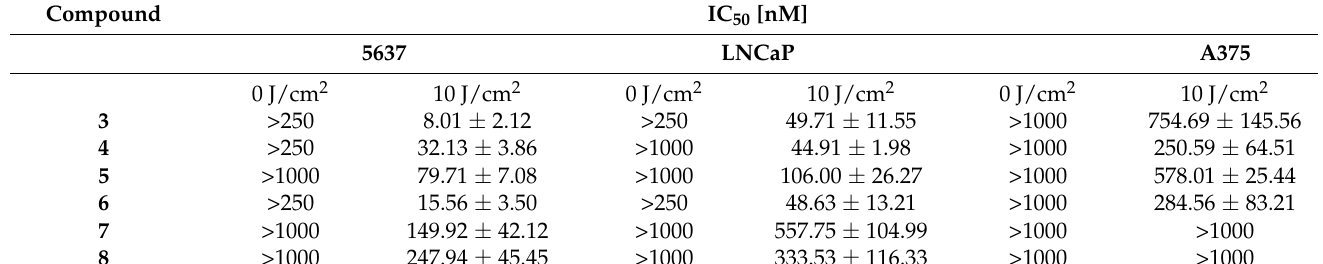
Table 5. The IC 50 values of 3 , 4 , 5 , 6 , 7 , 8 against 5637, LNCaP, and A375 cells. Data are expressed as the mean ± SD from at least three independent experiments.